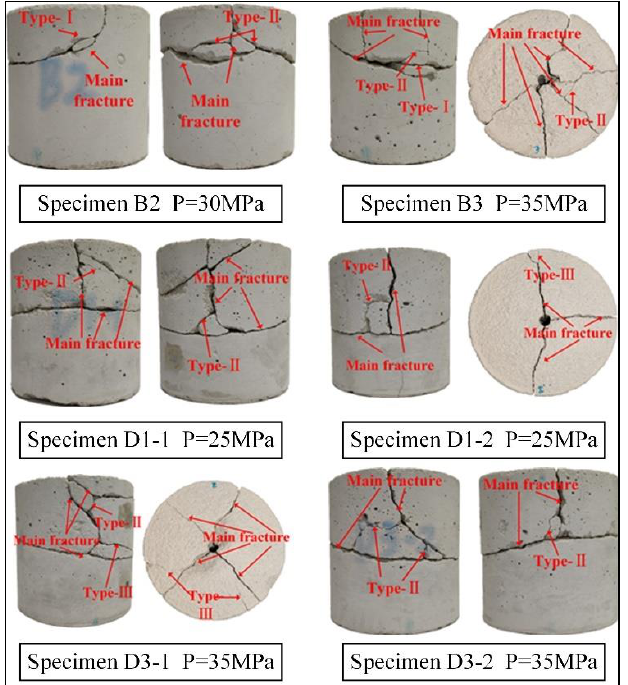
Figure 7. The digital images of fracture branches on the surfaces. Three types of fracture branches were summarized: type-I, initiating from a main fracture at a low angle and then converging to the main fracture; type-II, connecting two main fractures; type-III, initiating from a main fracture and connecting no fractures.